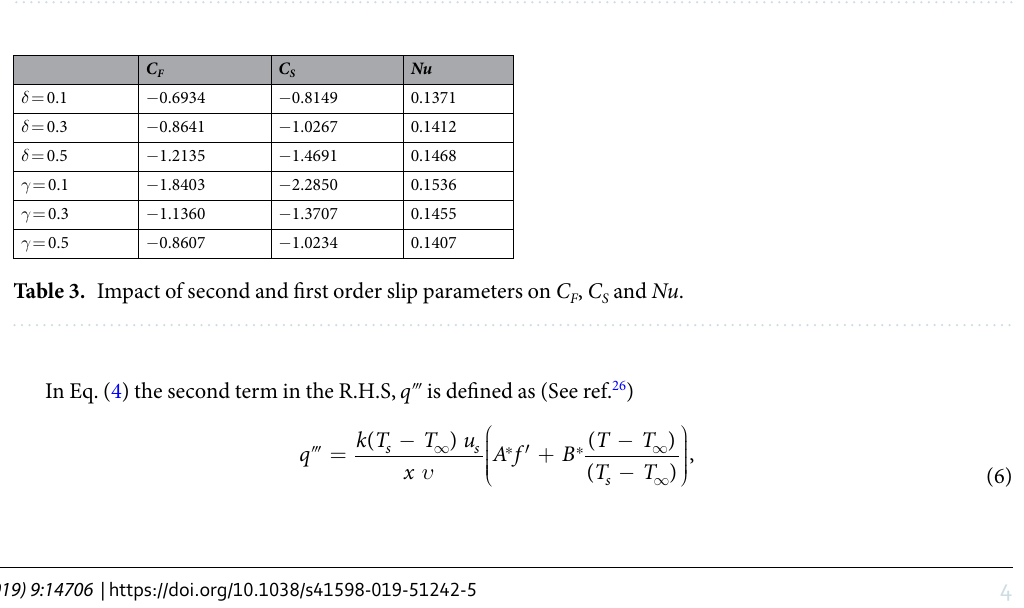
Table 2. Influence of sundry flow parameters on C F , C S and Nu for δ = 0 and δ = 1.